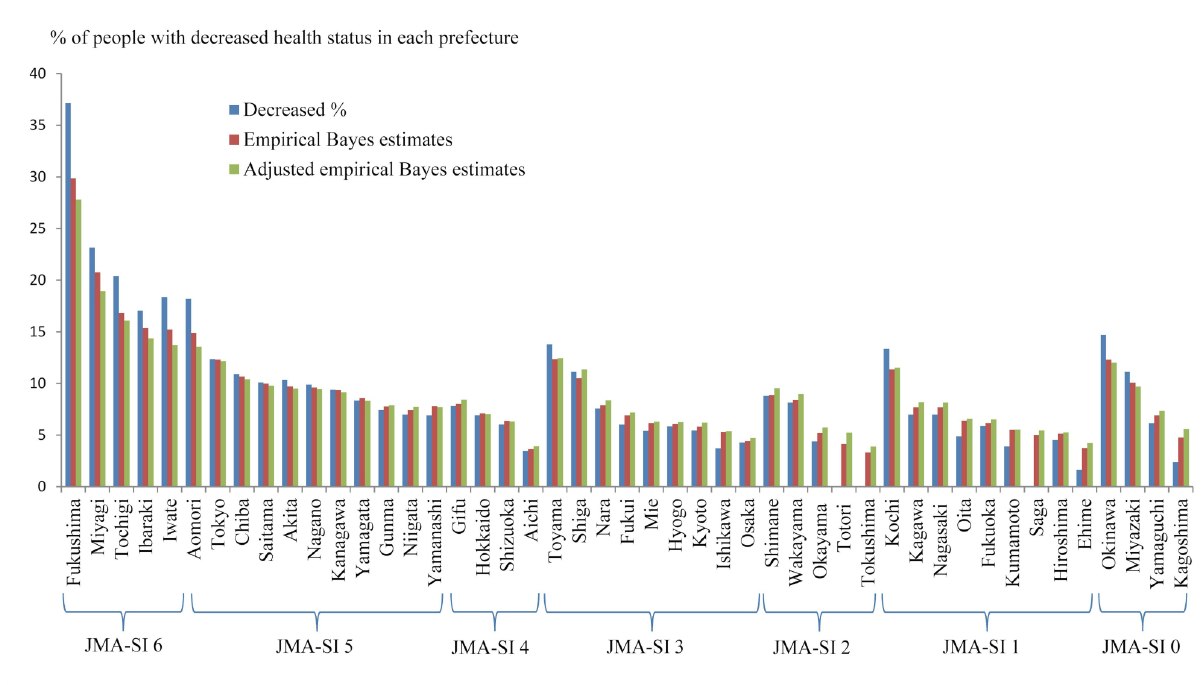
Figure 2. Percentage of respondents reporting decreased self-perceived health status and empirical Bayes estimates in each prefecture. JMA-SI, Japan Meteorological Agency Seismic Intensity. For the same JMA-SI levels, we determined the rank order of prefectures based on the values of adjusted empirical Bayes estimates. In adjusted empirical Bayes estimates, percentages were also adjusted according to demographic factors (gender, age, education, marital and employment status, changed job condition, income, death of family member[s], being a parent, family separation, and